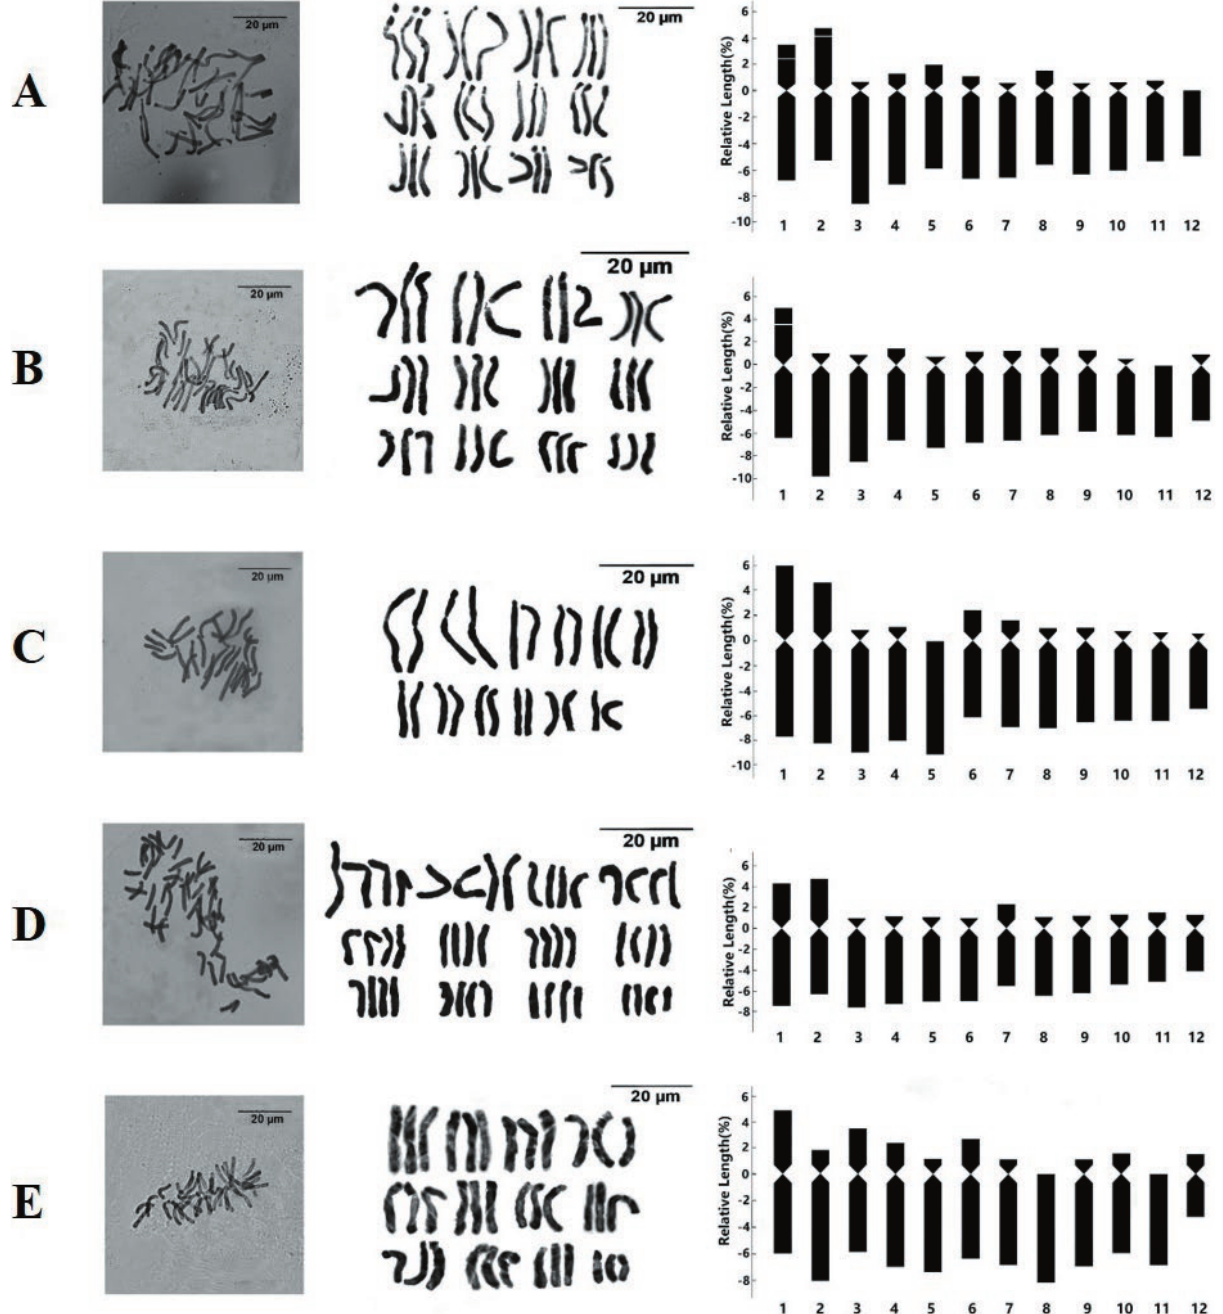
Figure 2. Mitotic chromosome plates, related karyotypes and karyograms of L. lancifolium and four related cultivars. A: L. lancifolium , B-E: L. lancifolium cultivars: 'Flore Pleno', 'Sweet Surrender', 'Red Life', 'Red Velvet',